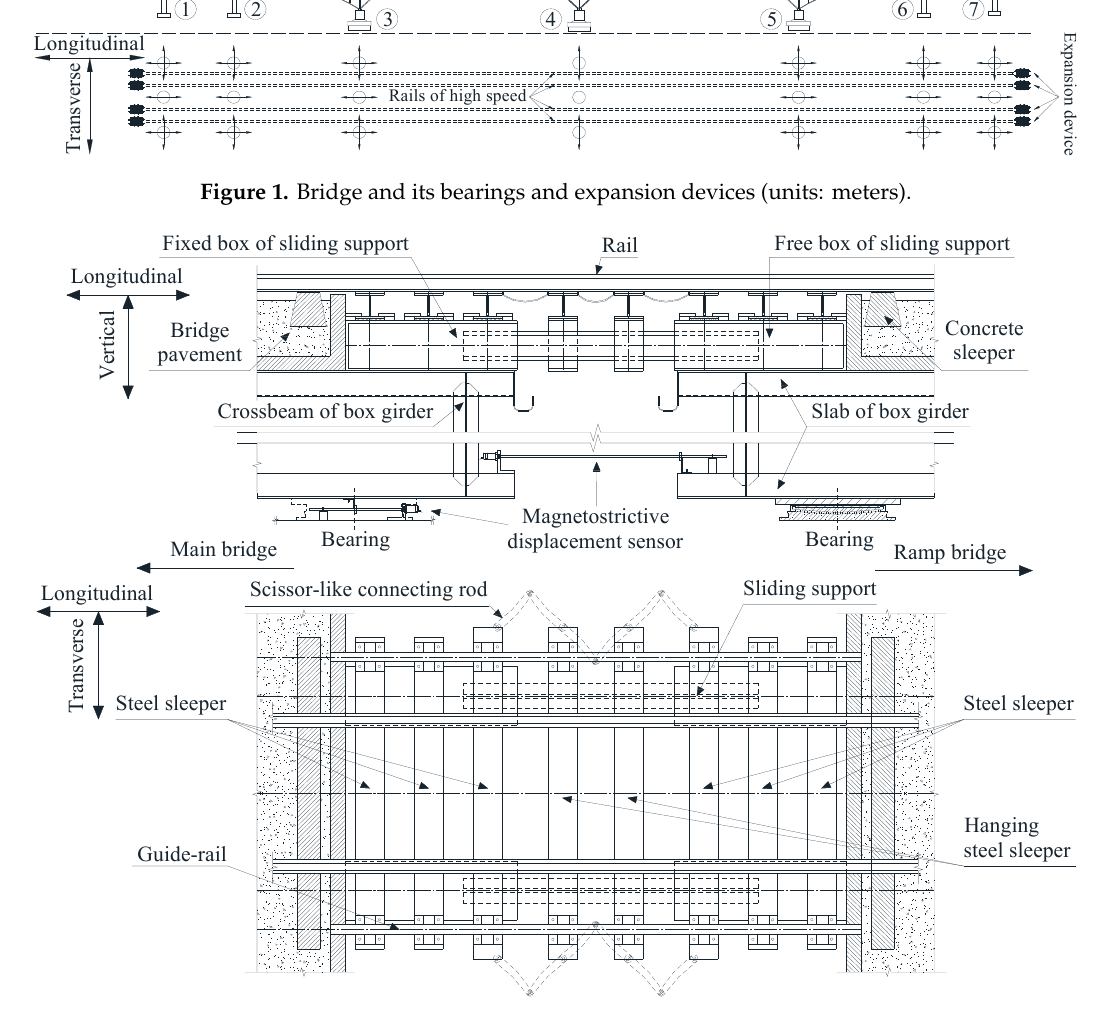
Figure 2. Expansion devices and bearings at Pier 7.